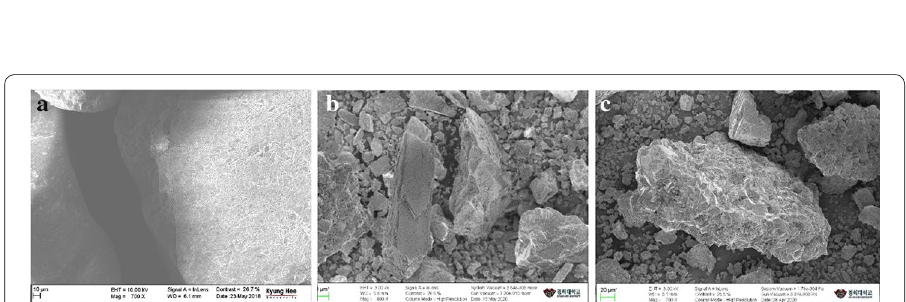
Fig. 7 The Scanning electron microscope (SEM) for test materials with size of 0.09–0.25 mm sand particle